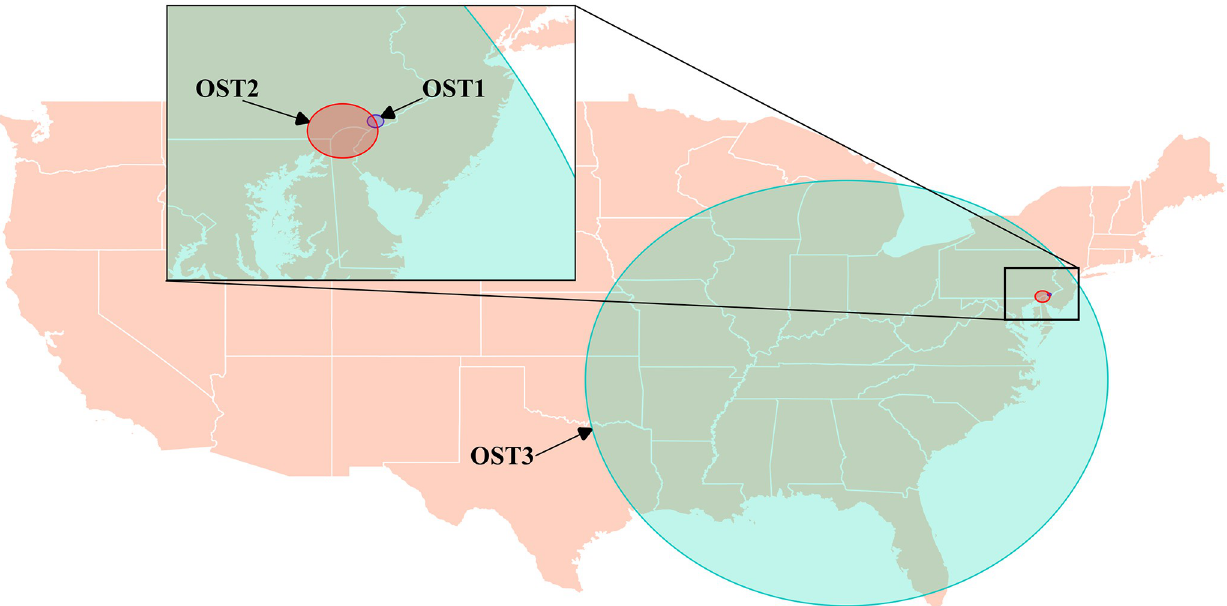
Fig 4. Locations of statistically significant space-time clusters of high levels of calls concerning opioids identified using the spatial scan statistic with Bernoulli and space-time permutation models, based on data from dog-associated poisoning calls to the Animal Poison Control Center related to opioids in the continental US (2005–2014).